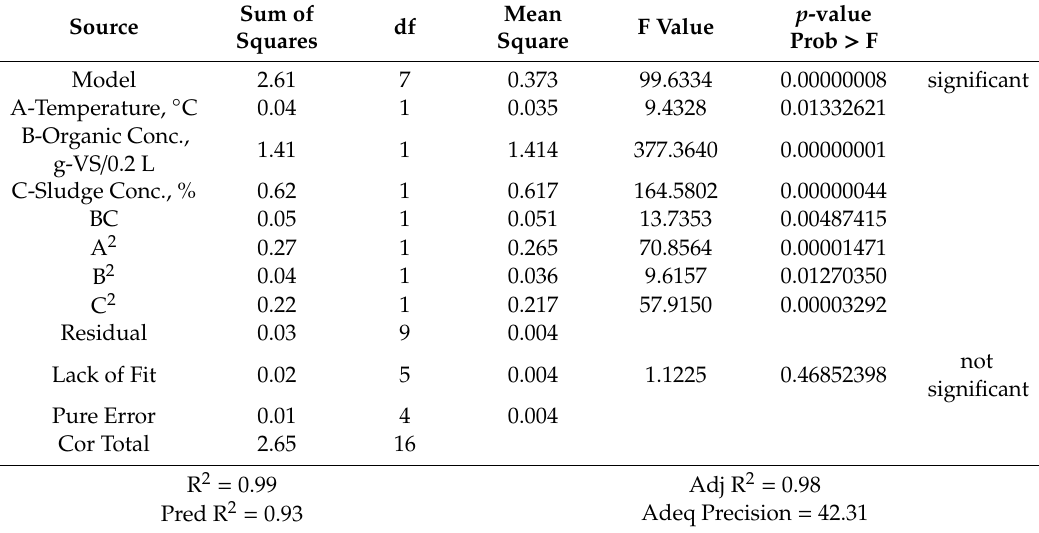
Table 5. The ANOVA table for the biogas volume produced from each g-VS / 0.2 L response. Sum Source